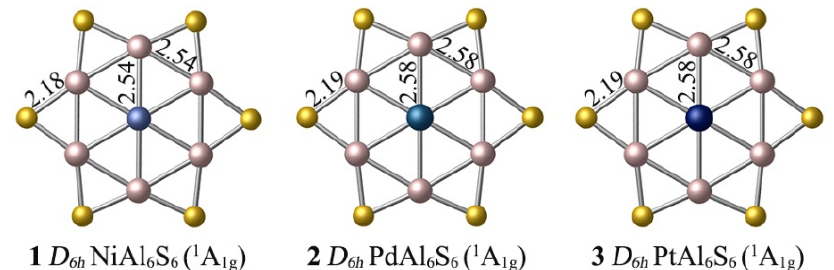
Figure 1. Optimized global-minimum structures 1 – 3 of MAl 6 S 6 (M = Ni, Pd, Pt) at the PBE0/def2- TZVP level. The bond distances are labeled in angstroms.